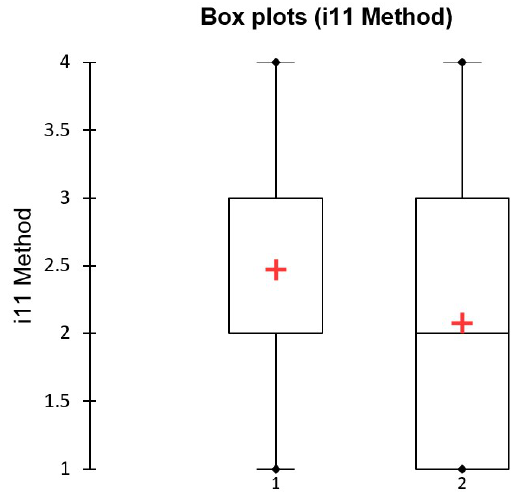
Figure 8. Box plot of the average score of Item 11 (presentation of the contents of the programs) according to whether the program is general or specific.